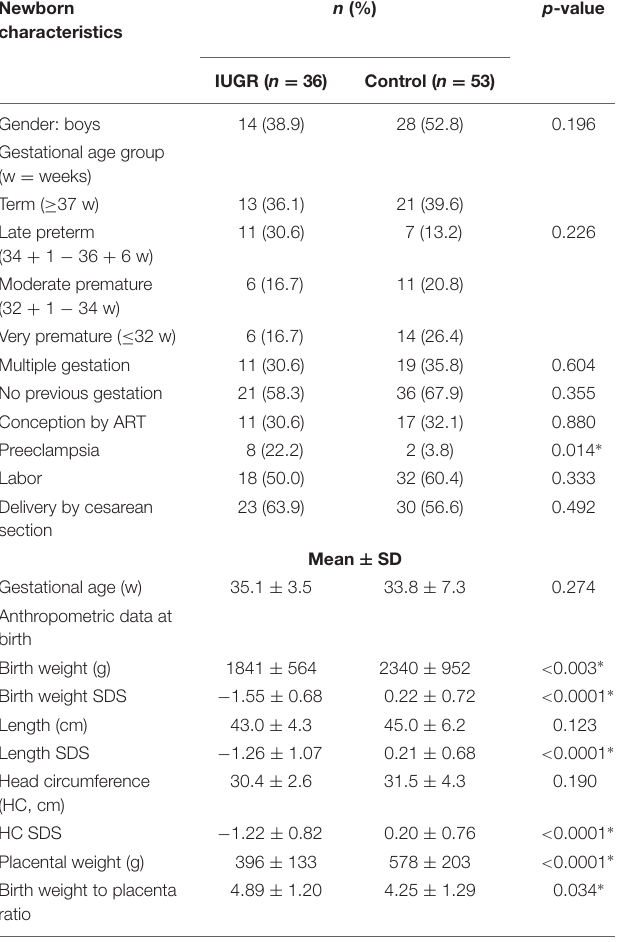
TABLE 1 | Clinical characteristics of the newborns in the